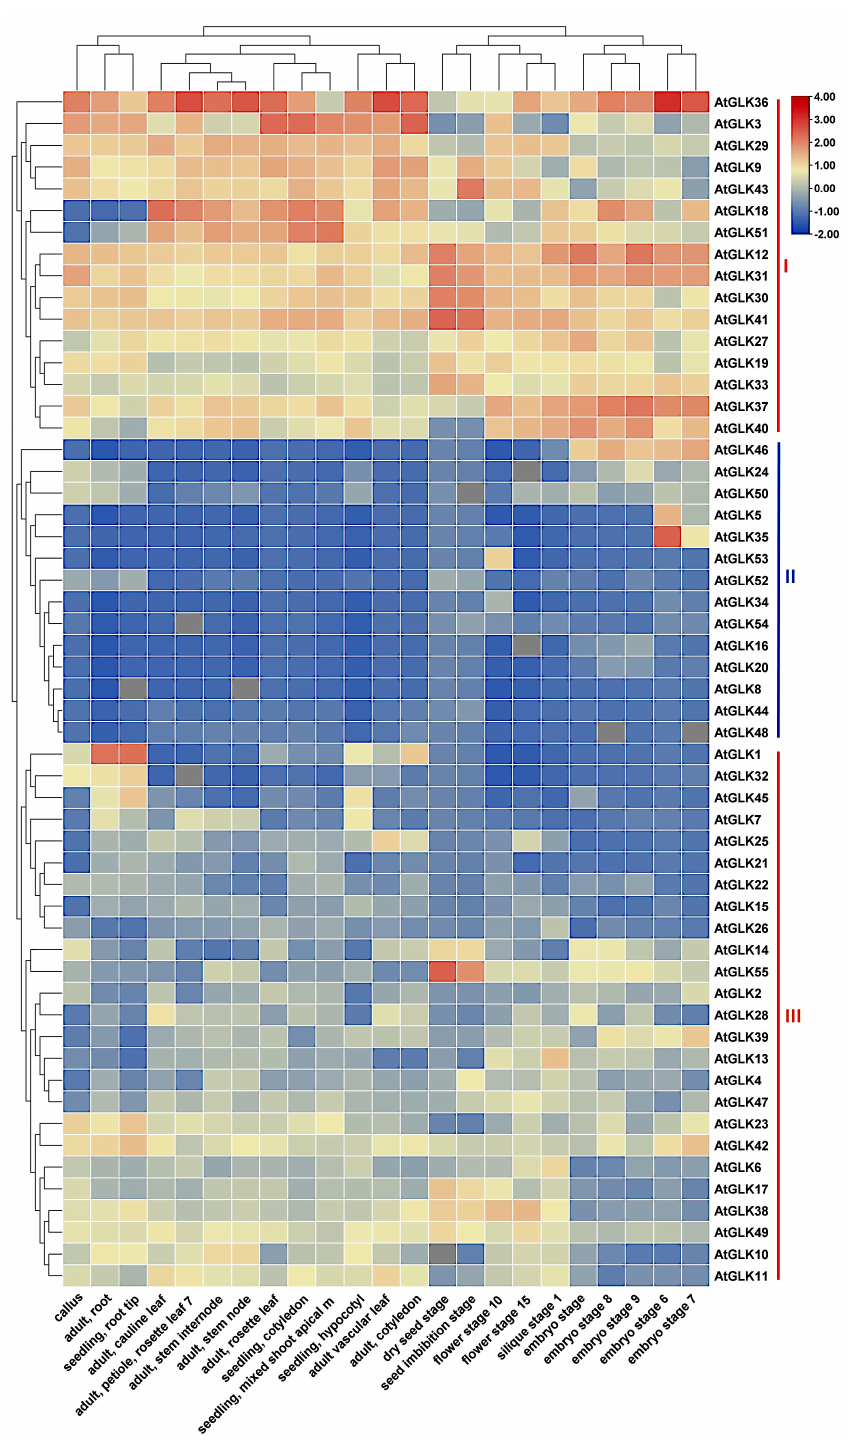
Figure 3. Expression pattern of AtGLK genes in 23 various plant tissues or organs. The heatmap was constructed using the Arabidopsis tissue atlas accession number E-MTAB-7978 of Arabidopsis development (AtGenExpress Developmental Expression Atlas) defined by Schmid et al. [35]. The color scale at the bottom of the heatmap shows log2 transformed FPKM values. The 55 AtGLK genes were clustered according to the log2-transformed FPKM values. The types of tissues are presented on the bottom side. The gene names are presented in the right position in the heatmap. The expression scale highlights the relative expansion values and is presented at the right position of the